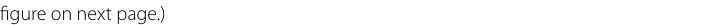
figure on next Fig. 9 Temporal variations and probability density distributions of b in regions of low p -values for N the analysis periods (from the first to the N th earthquake). a Low and b high b -value regions that may be related to large earthquakes in area A. c Regions of steadily low b -values in area A. d Regions of steadily high b -values in area A. e Low and f high b -value regions in area B. In a and b , the time variation is shown with respect to the elapsed time from the large earthquake that seems to have caused the largest effect on the seismic activity shown in the legends. The left and middle panels show variations before and after the large earthquakes, respectively. Numbers in square brackets in the legend in the right panels indicate the number of estimated index values. The regions correspond to those shown in Fig. 7. The arrows in c show the times when slow slip was detected near region L (off Boso Peninsula). PDDs in right panels in d and e exclude the activities in regions g and R (the Izu islands),